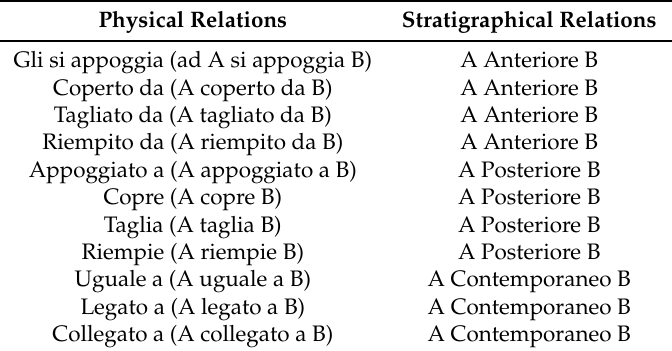
Table 1. Link between physical and stratigraphical